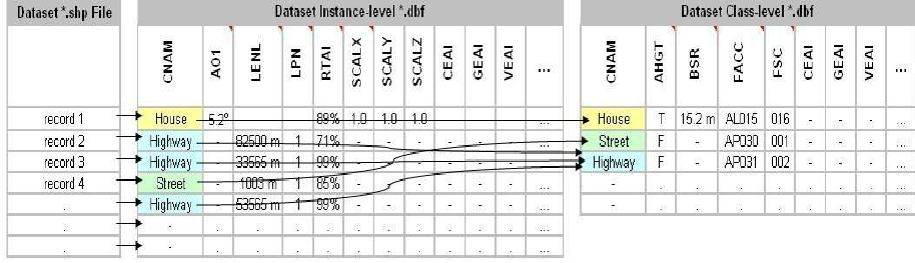
Figure 7. An example of Instance-level and Class-level attribution schema in vector shapefiles [15].